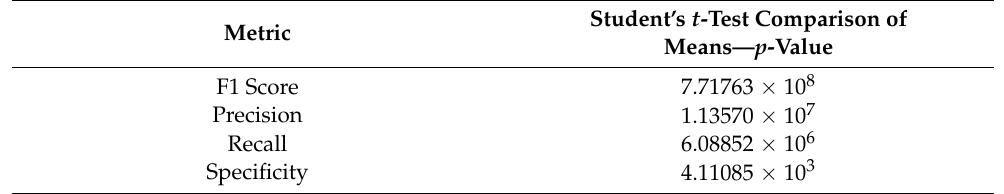
Table 11. Mean comparison hypothesis test for dataset PH2.